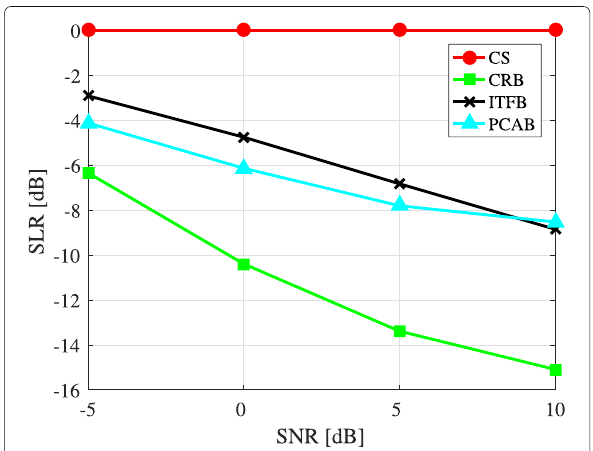
power. The CRB achieves the lowest SLR. This is because for CRB, the effective error of the channel identification can be appropriately approximated by a common trans- fer function. The SLR in ITFB at low SNR is large because ITFB faces greater difficulties in the unbiased estima- tion of interaural transfer functions. This is because the respective Wiener solution of the filter is biased by the noise PSD [30]. Due to the inverse filtering problem in ITFB, the SLR cannot be reduced even at high SNRs.